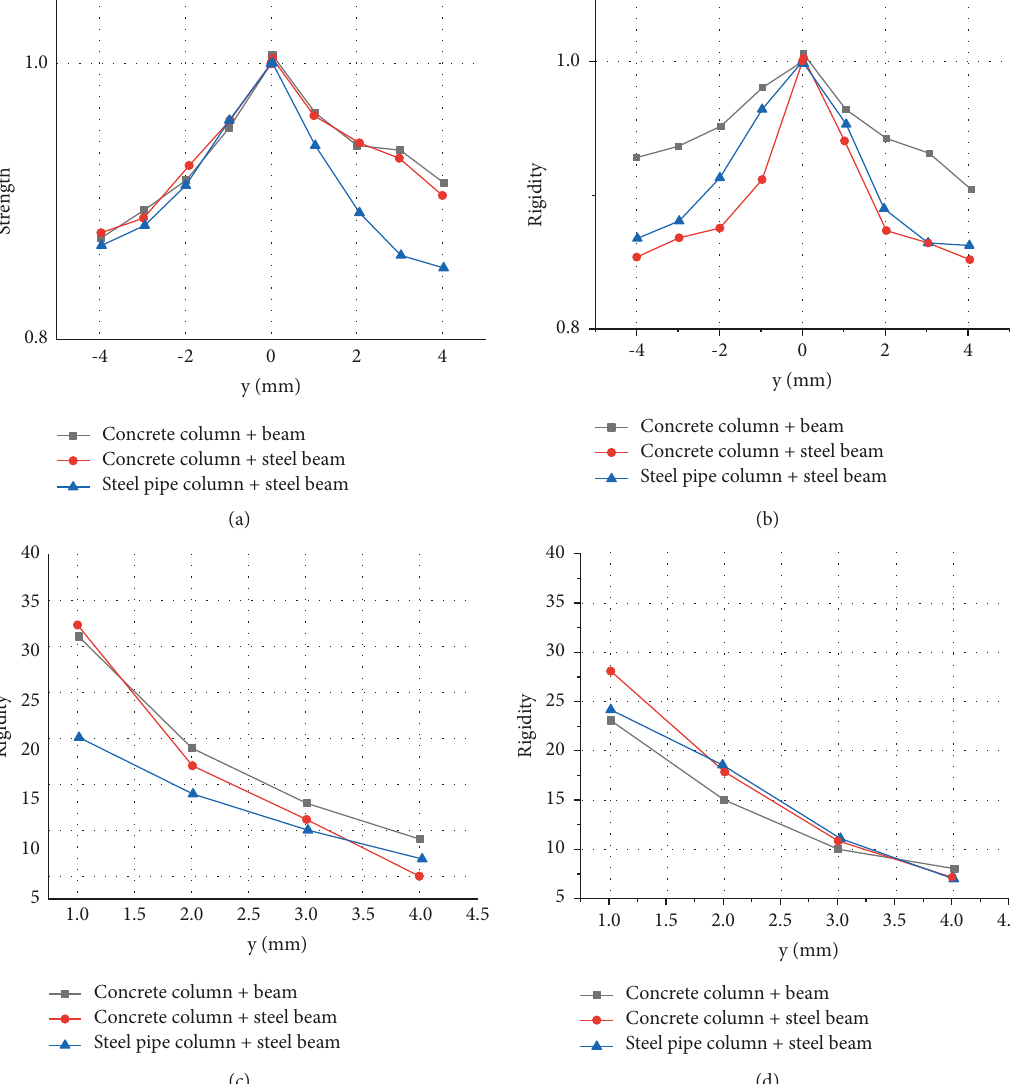
Figure 10: Bending stiffness and strength degradation curves: (a) bolt-type bending stiffness; (b) external diaphragm-type bending stiffness; (c) bolt-type bending stiffness; (d) external diaphragm-type bending